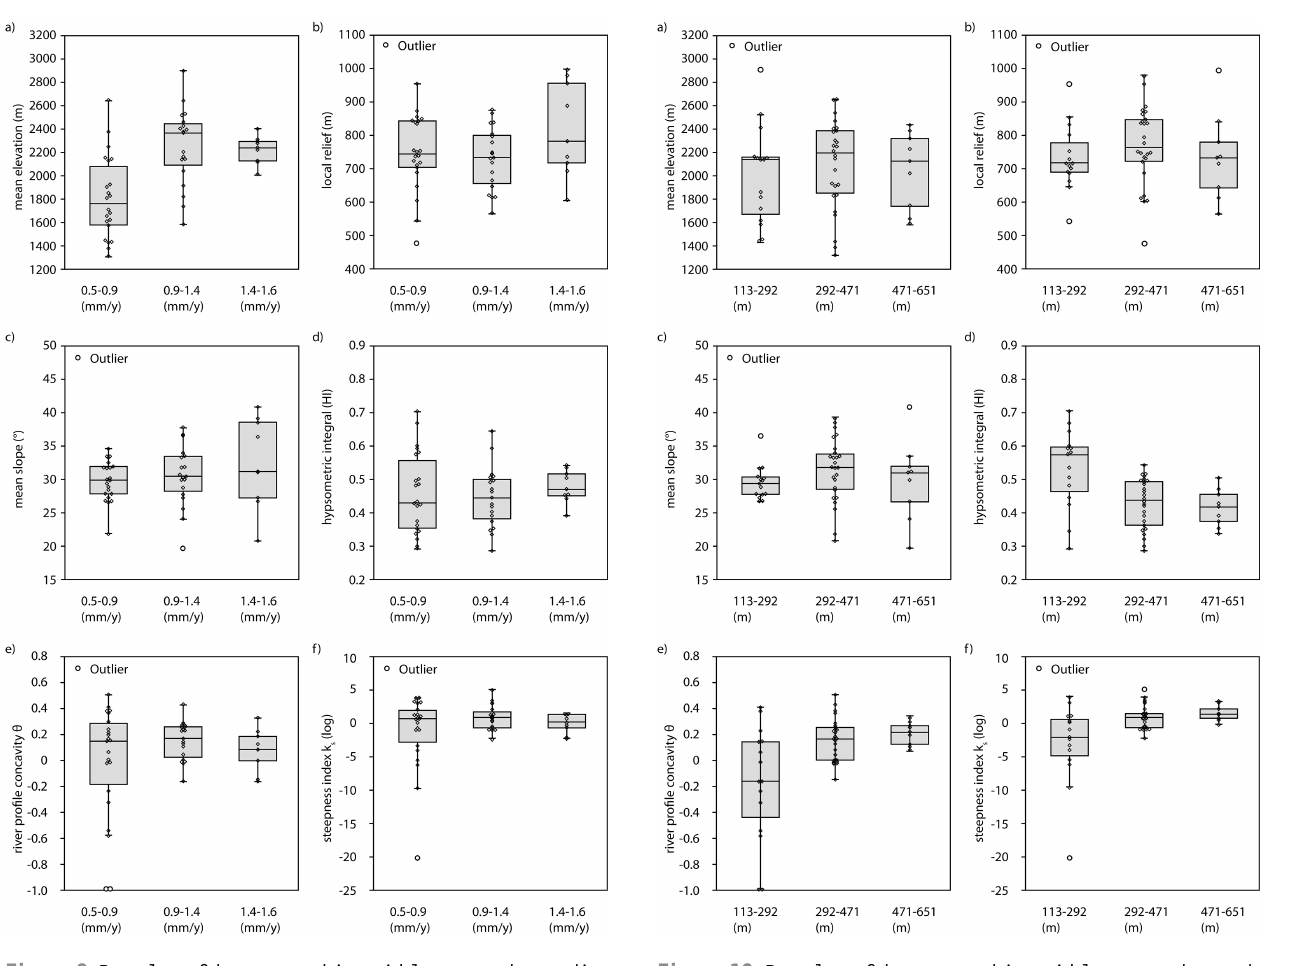
Figure 9. Boxplots of the topographic variables grouped according to the recent uplift rates (Schlatter et al., 2005), which give short- term uplift information.